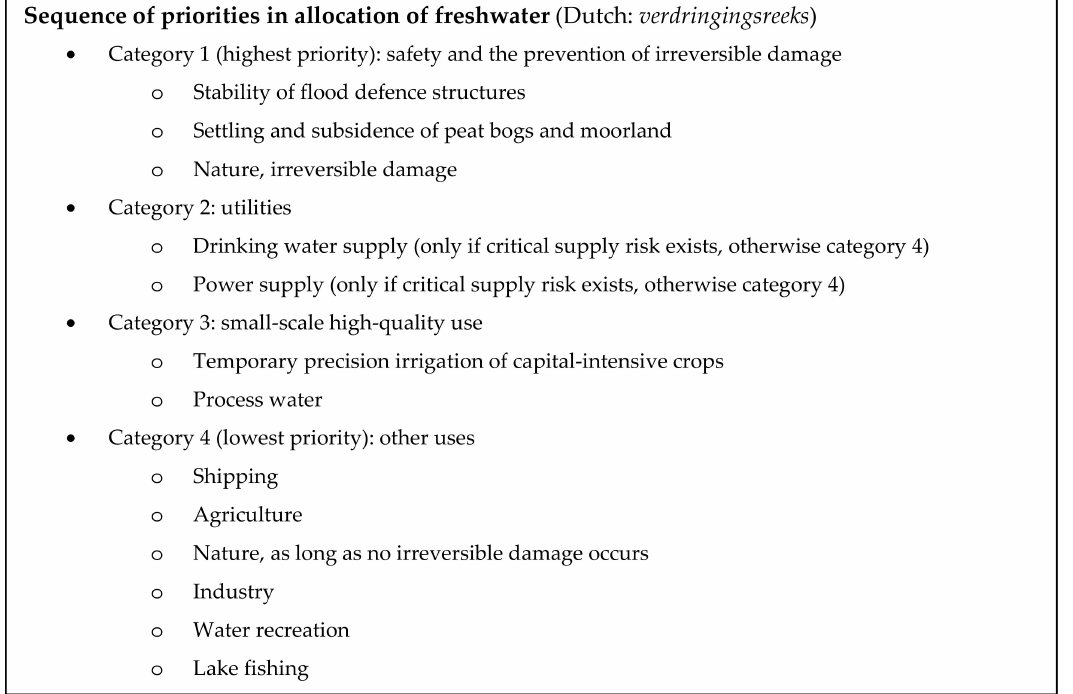
Figure 4. Sequence of priorities in allocation of freshwater